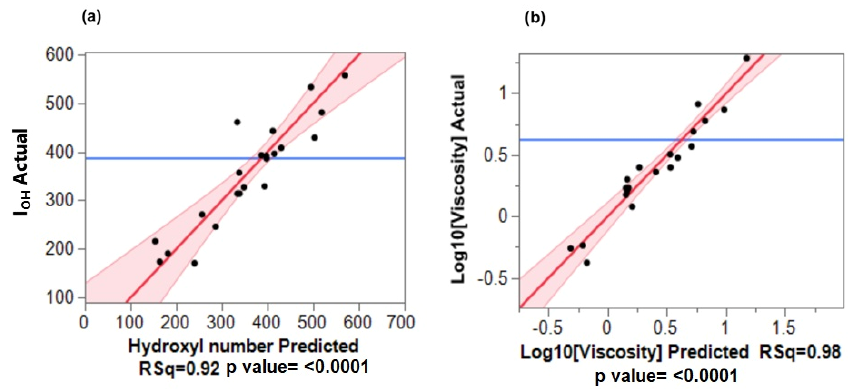
Figure 5. ( a ) Plots of actual versus predicted values of I OH , ( b ) Plots of actual versus predicted values of viscosity.